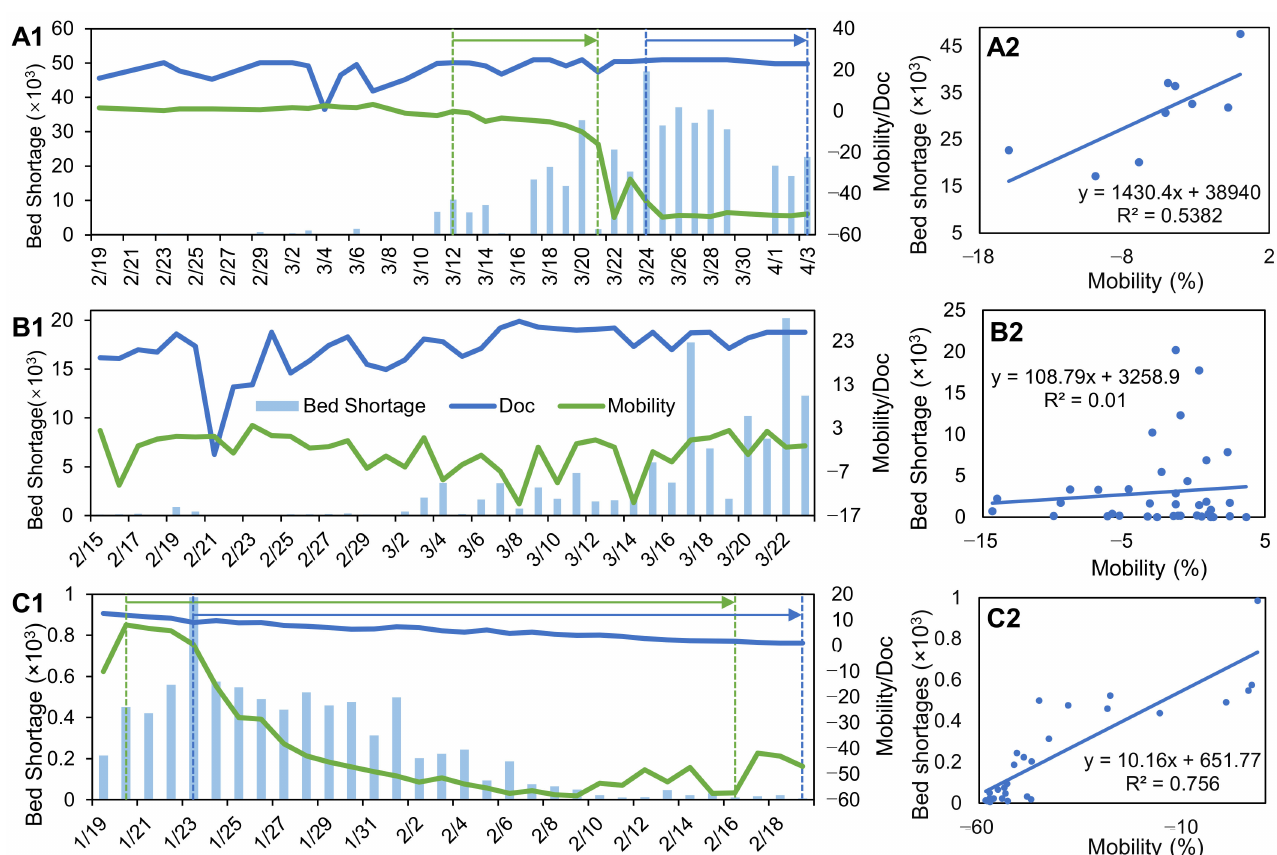
Figure 5. Dynamics of local D oc , intra-country mobility and hospital bed shortages in India ( A1 ), Japan ( B1 ) and China ( C1 ). ( A2 ), ( B2 ) and ( C2 ) denote the relationship between intra-country mobility and estimated bed shortages. Note that we consider the lagged relationship between the reduction of mobility and bed shortage by estimating the relationship in ( A2 ) and ( C2 ) using the mobility and bed shortage data in the period marked by green and blue arrows in ( A1 ) and ( C1